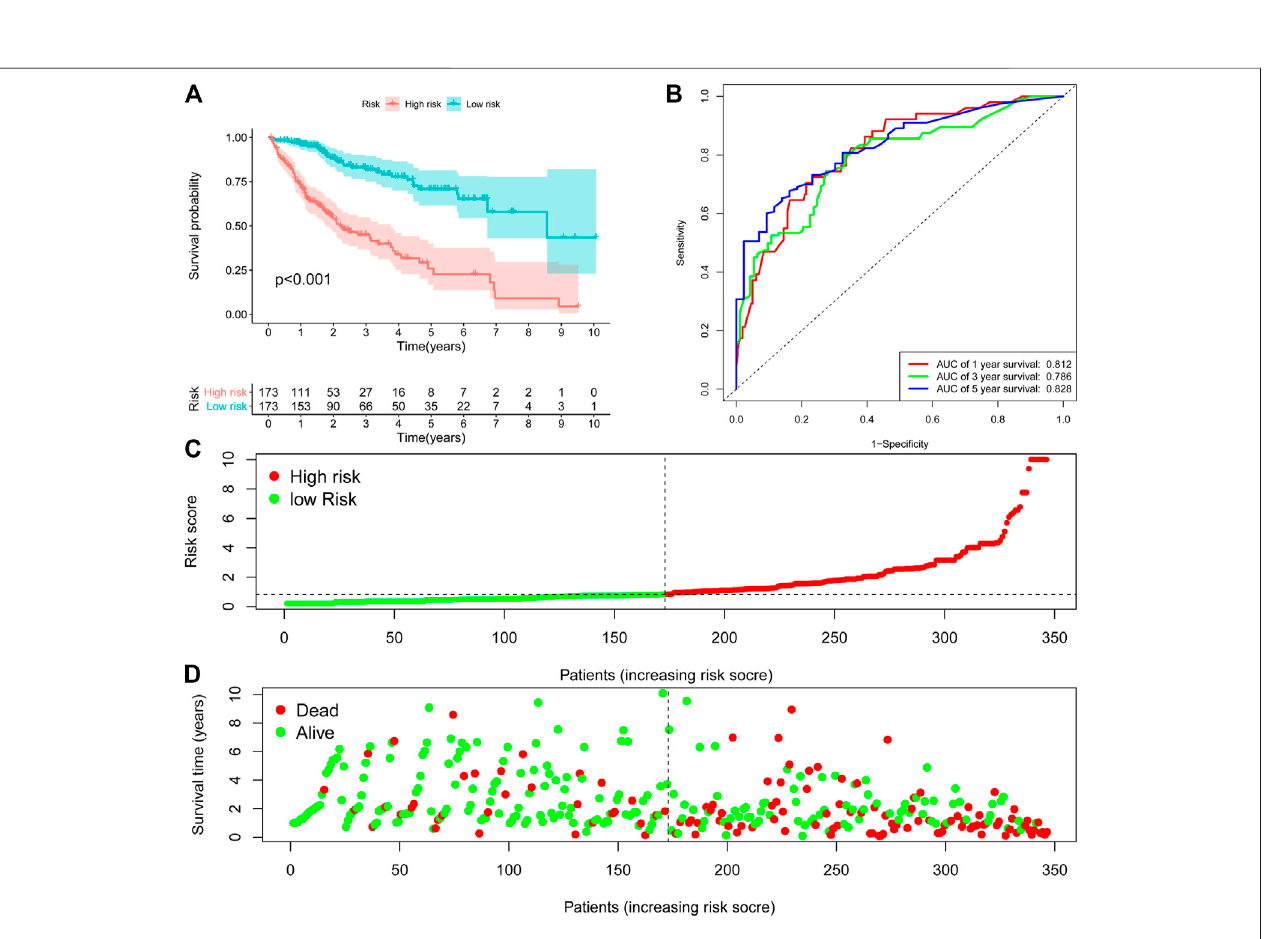
FIGURE 1 | Establishment 9-ARGP signature in the TCGA database. (A) Kaplan-Meier survival curves showed the prognostic value of the risk signature between low-risk group ( n (cid:1) 263) and high-risk group ( n (cid:1) 262). (B) ROC curves were used to assess the ef fi ciency of the risk signature for predicting 1-, 3- and 5-y survival. (C) The risk scores distribution in the TCGA database. (D) The patients survival status in the TCGA database.